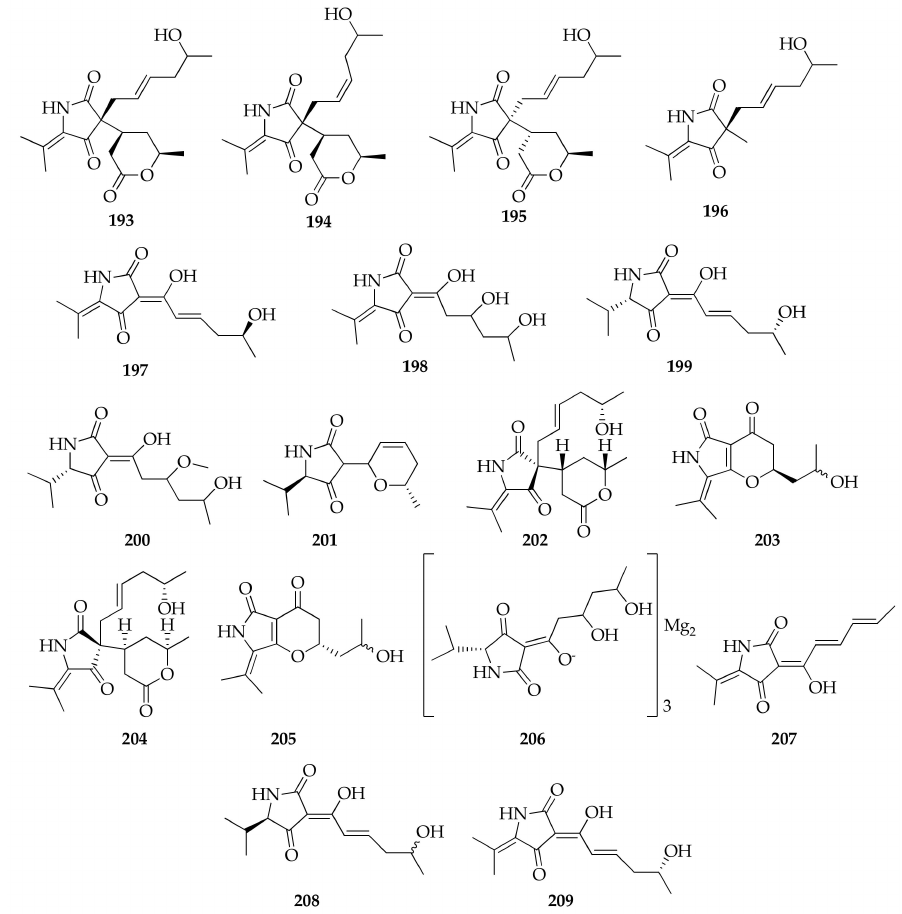
Figure 28. Structures of cladosporiumins.